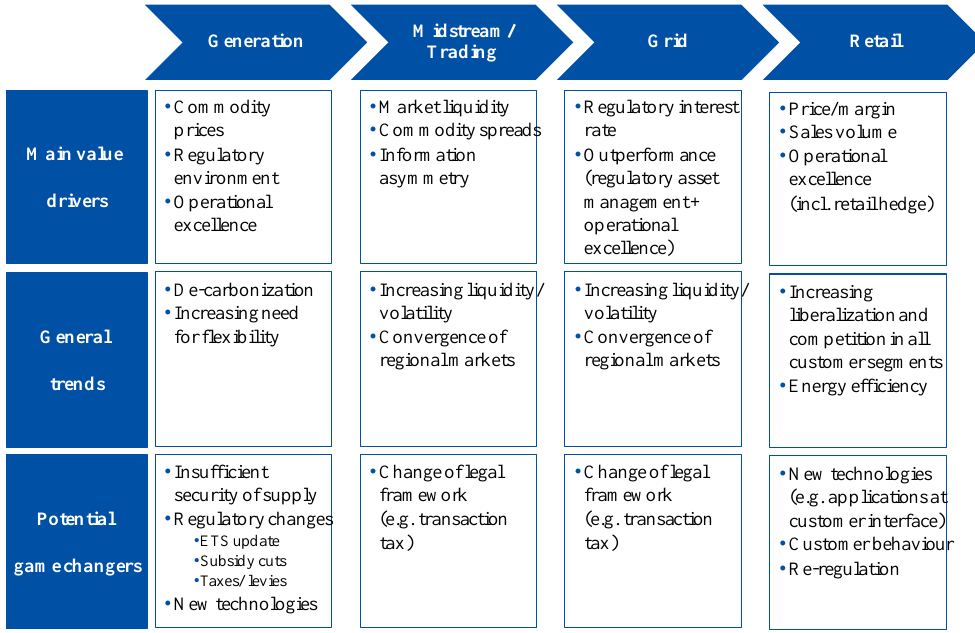
Figure 18. Overview of the main value drivers, general trends, and potential game changers in the most important stages of the value chain for RWE. Own illustration, based on internal RWE information.